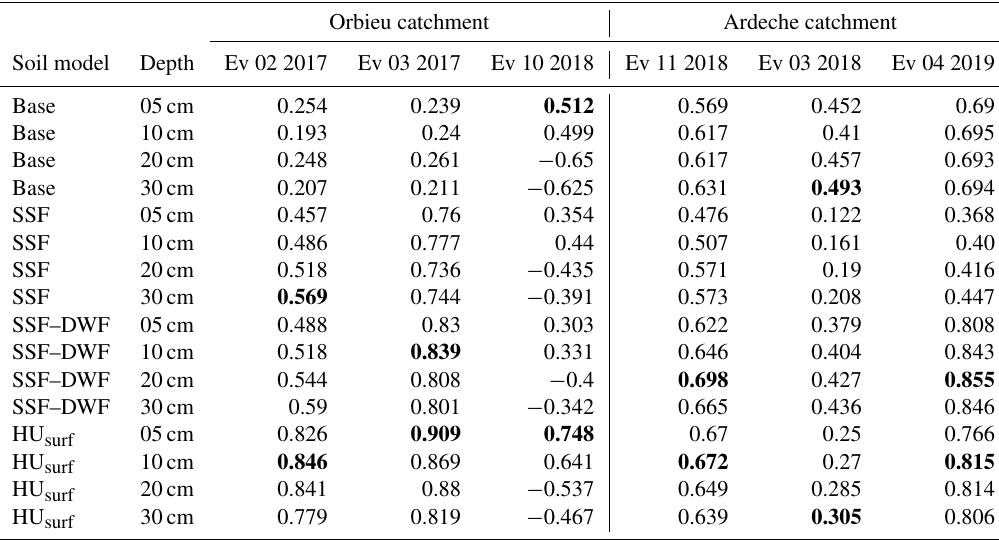
Figure 5. SMOSMANIA SSD measurements at the four sensor depths for the Barnas (Ardeche catchment) and the Mouthoumet (Orbieu catchment) stations, together with the SSD simulated with MARINE, the LDAS-Monde HU surf , and the CGLS SWI when available at the measurement point location. For the MARINE simulations using the SSF–DWF soil model, the moisture of the surface layer is considered here. Table 5. Kendall correlations between SMOSMANIA measurements at each depth and the MARINE SSD simulated with each soil model or the LDAS-Monde HU surf . The values in bold are the best correlations between the SMOSMANIA measurements and the MARINE outputs or the LDAS-MONDE HU surf for each